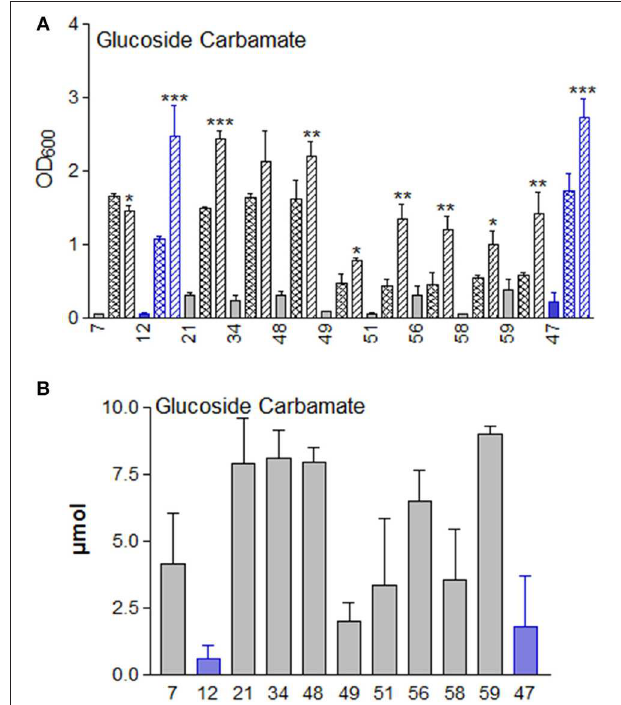
FIGURE 14 | (A) Glucoside carbamate supplementation significantly stimulates the growth of the microorganisms in Czapek medium, except for strain 7, in comparison to the controls without glucoside carbamate. OD 600 culture start, ; OD 600 after 72 h: control, ; OD 600 in presence of glucoside carbamate, . Microorganisms: Mycobacterium fortuitum (7), Bacillus aryabhattai (34), Bacillus cereus (59), Bacillus megaterium (21, 48), Bacillus methylotrophicus (58), Lysinibacillus xylanilyticus (56), Paenibacillus polymyxa (51), Aminobacter aminovorans (49), the fungi Papulaspora sepedonioides (12), and Trichoderma viride (47) . Blue bars: fungi; gray bars: bacteria. (B) Glucoside carbamate can be converted back to BOA- N -glucoside by M. fortuitum (7) , P. sepedonioides (12) , A. aminovorans (49) , P. polymyxa (51) and T. viride (47) . M. fortuitum (7) , P. polymyxa (51) and B. methylotrophicus ( 58) reduced the content of the compounds without BOA accumulation. * p < 0.05; ** p < 0.005; *** p <